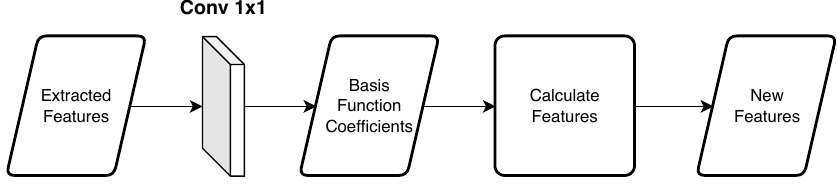
Figure 4. Overview of the basis function